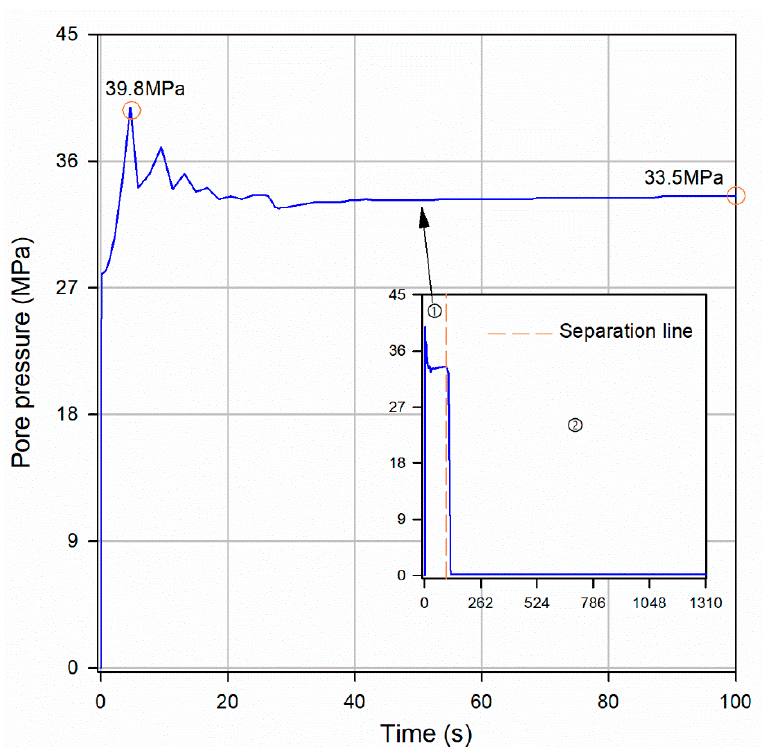
Figure 5. The change in pore pressure during the fluid injection process in the benchmark model. ① Fluid is injected into the central perforation in the reservoir of the model for 100 s, and pore pressure rapidly rises to the breakdown pressure and gradually stabilizes at a stable level. ② Injection is stopped, and the hydraulic fracture keeps open, proppant acts at this stage, and then dissipated pore pressure activates the production pressure di ff erence to make the fluid move back through the fracture. The research focus is on the fluid injection stage when SRV is